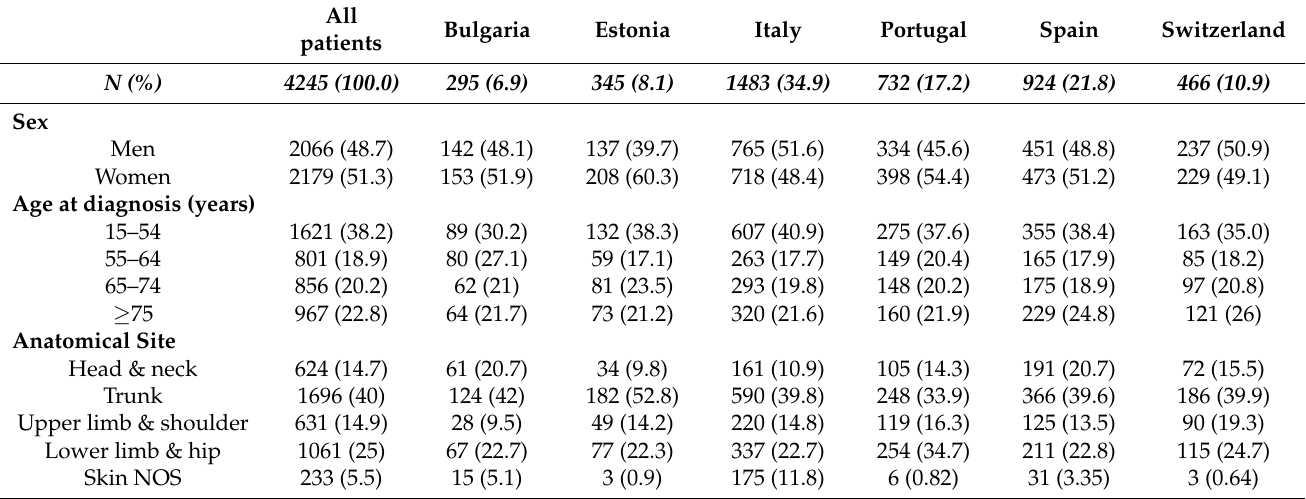
Table 1. Distribution and clinical and pathological characteristics of 4245 operated cutaneous melanoma patients diagnosed in 2009–2013 in six European